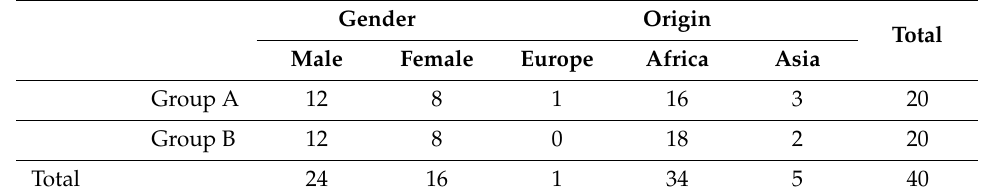
Table 3. Characteristics of the sample. Gender and origin.